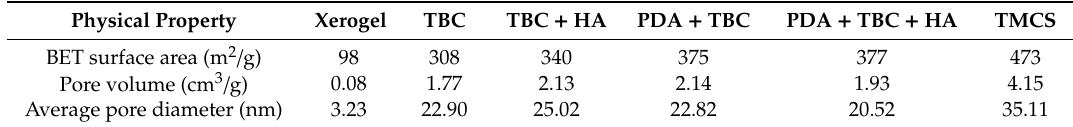
Figure 2. Scanning electron microscopy (SEM) images of ( a ) xerogel, ( b ) TBC, ( c ) TBC + HA, and ( d ) trimethylchlorosilane (TMCS)-modified aerogel. ( e , f ) Fourier transform-infrared spectroscopy (FT-IR) spectra of xerogel, TBC-modified aerogel, TBC + HA-modified aerogel, and TMCS-modified aerogel. Table 1. Results of Brunauer–Emmett–Teller (BET) analysis.